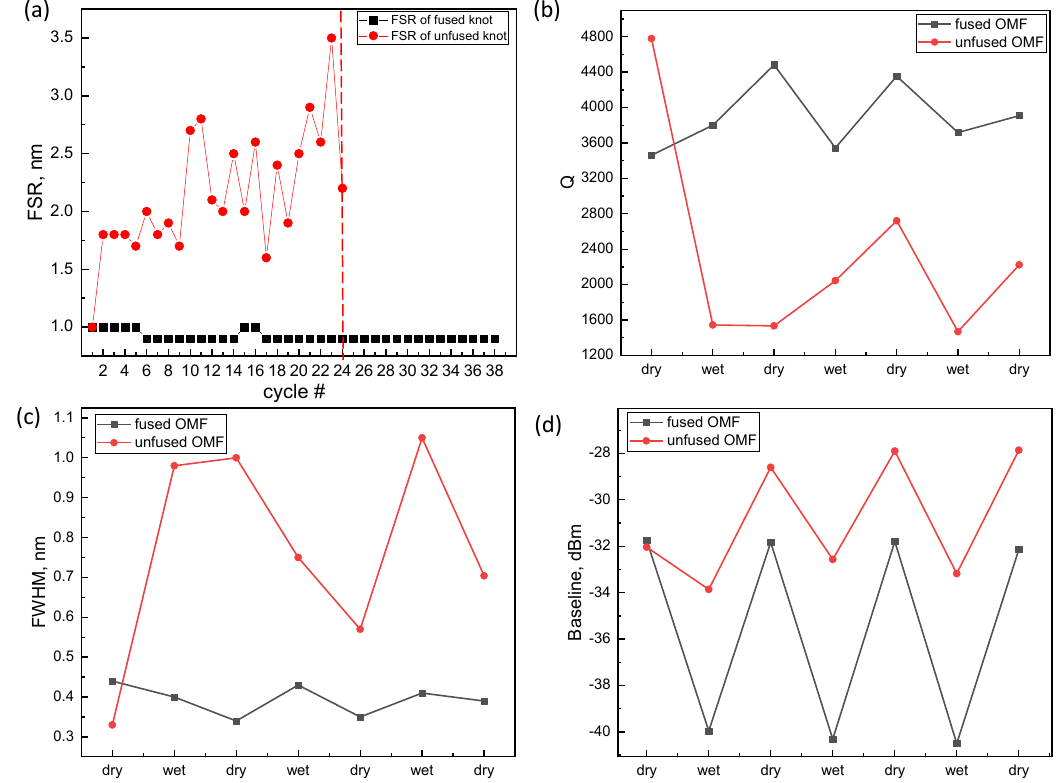
Figure 4. Comparison of derived parameters in fused (black rectangles) and unfused (red circles) OMFs as a function of wetting/drying cycles in ethanol. ( a ) Free spectral range. Breaking point is illustrated by the red dashed line, ( b ) Quality factor; ( c ) Full width at half maximum; ( d )